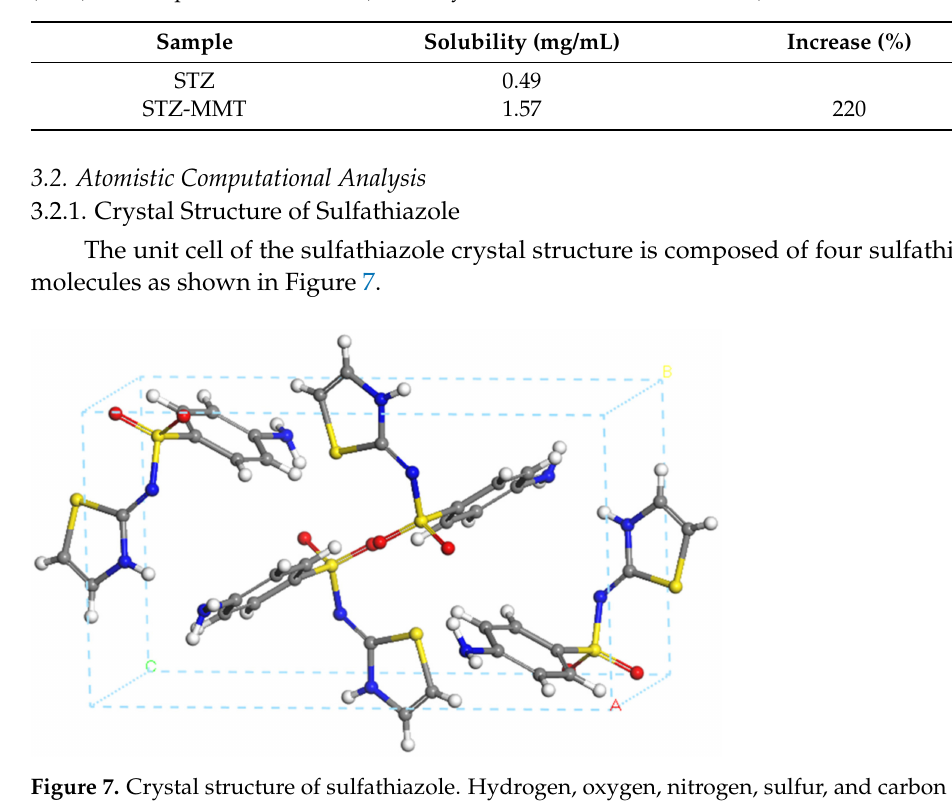
Table 2. Aqueous solubility values (in mg/mL) of STZ and STZ-MMT IP and increase solubility (in %) with respect to that of STZ (solubility mean values ± 0.01 SD; n = 5).